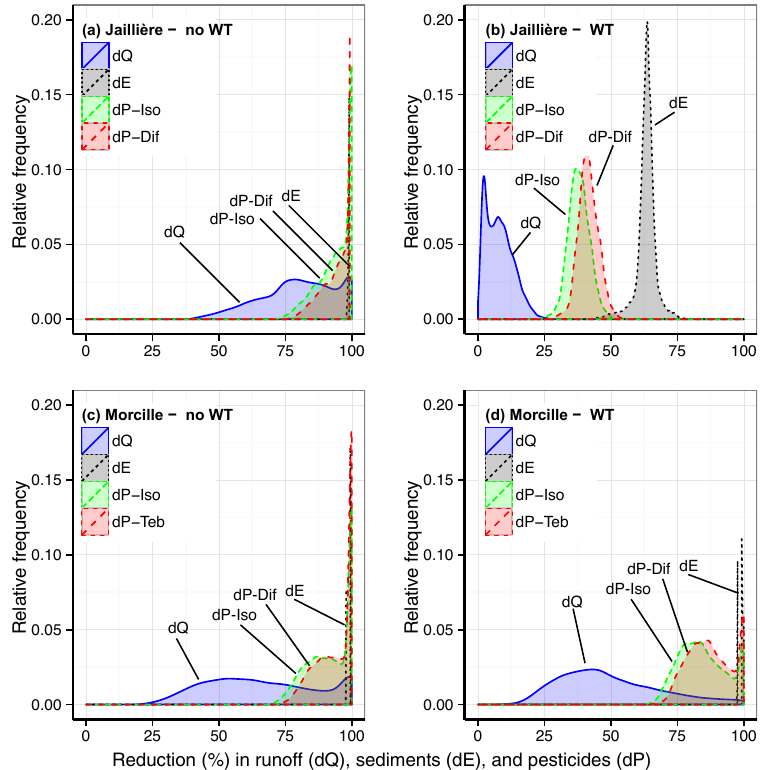
Figure 7. Probability density functions from the uncertainty analysis of eFAST simulations on output variables d Q (reduction of surface water), d E (reduction of sediment), and d P (reduction of pesticides) for the Jaillière (a–b) and Morcille (c–d) sites, without water table (no WT) and with water table (WT). Pesticides are isoproturon (Iso), diflufenican (Dif), and tebuconazole